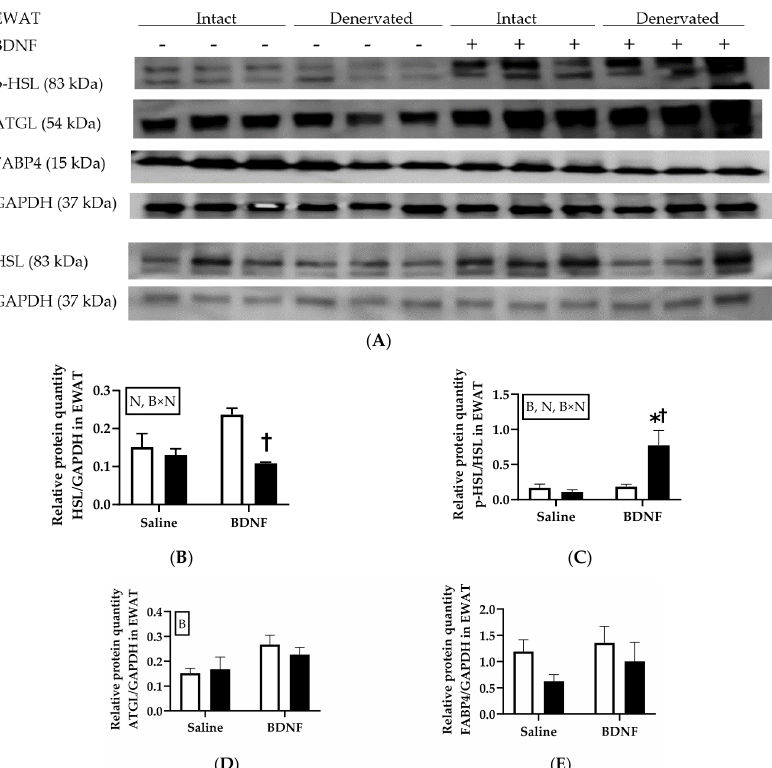
Figure 4. Expression of lipolytic p-HSL, HSL, ATGL, and FABP4 in intact and denervated epididymal white adipose tissue (EWAT) of intracerebroventricular saline- or BDNF-treated rats. Quantifications of p-HSL, HSL, ATGL, and FABP4 were normalized to GAPDH. Quantifications of p-HSL / GAPDH were also normalized to HSL / GAPDH to obtain p-HSL / HSL. ( A ) Representative western blot images of expression of p-HSL, HSL, ATGL, and GAPDH; and quantifications of ( B ) HSL / GAPDH, ( C ) p-HSL / HSL, ( D ) ATGL / GAPDH, and ( E ) FABP4 / GAPDH in intact (open bar) and denervated (filled bar) EWAT of saline- or BDNF-treated rats. Two-way ANOVA with the factors “innervation” (N; intact vs. denervated) and “BDNF” (B; icv saline vs. BDNF treatment) and multiple comparisons post hoc Tukey’s test were used to compare relative protein quantities. * Represent significant di ff erences relative to saline-treated rats ( p < 0.05). † Represent significant di ff erences relative to denervated adipose tissue ( p <